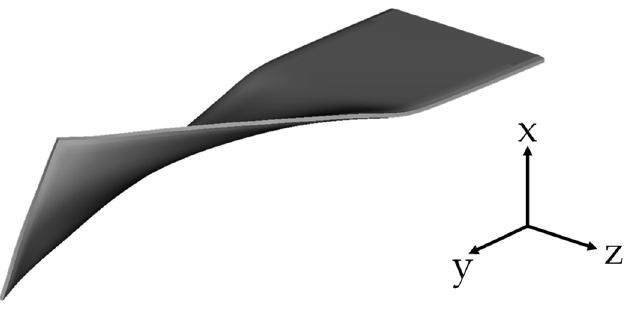
Figure 1. Structure and principle of the processing machine: ( a ) taper roller and ( b ) roller arrangement.